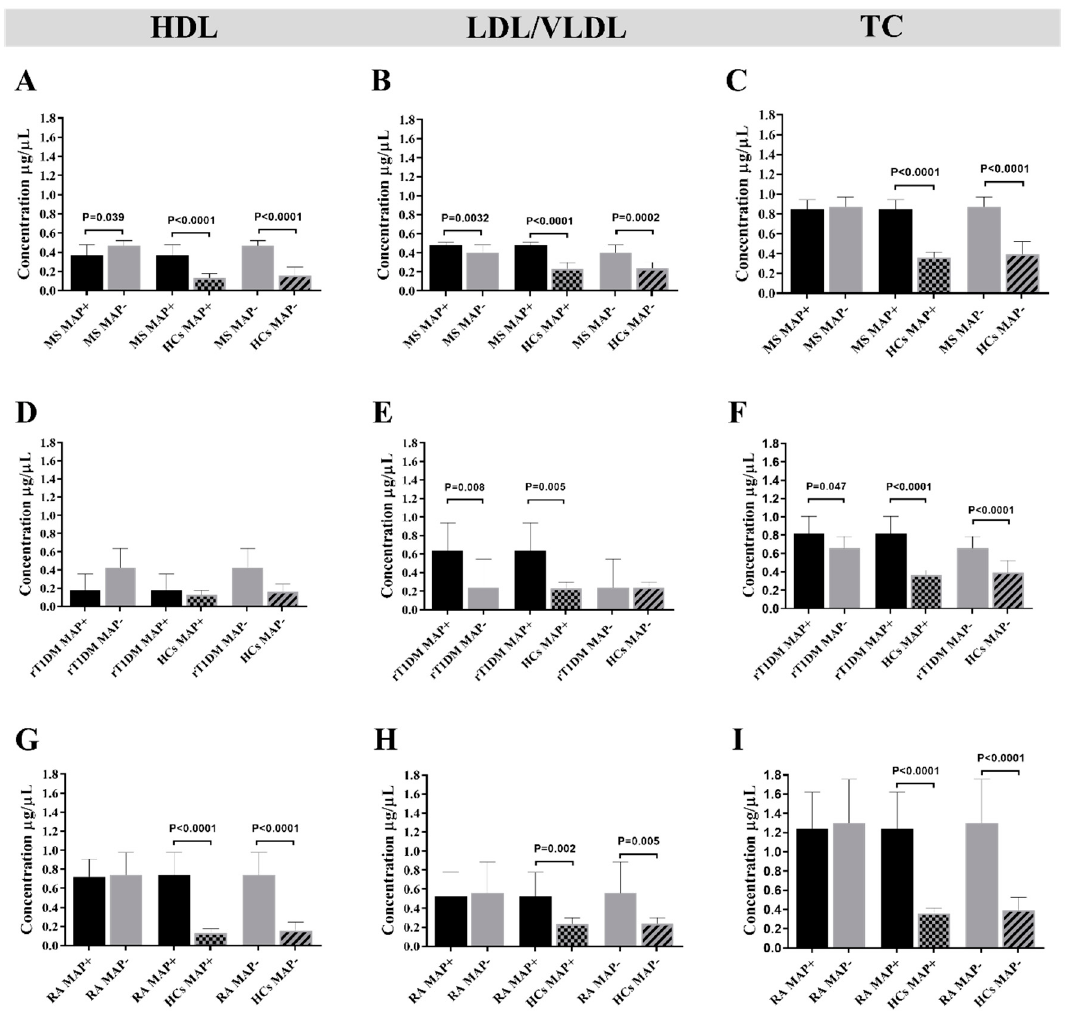
Figure 2. Disease-related concentrations of high density lipoprotein (HDL), low density lipoprotein (LDL) and total cholesterol (TC) assessed based on positivity to MAP antigens. The analysis was performed by comparing MAP+ versus MAP- subjects among patients affected by MS ( A–C ), at risk of T1DM (rT1DM) ( D–F ) and RA subjects ( G–I ). Additionally, a comparison of patients and healthy controls (HCs) was carried out for the same MAP-related serological status. Statistical significance is reported above relative bars when attained. For each group, standard deviation is indicated.